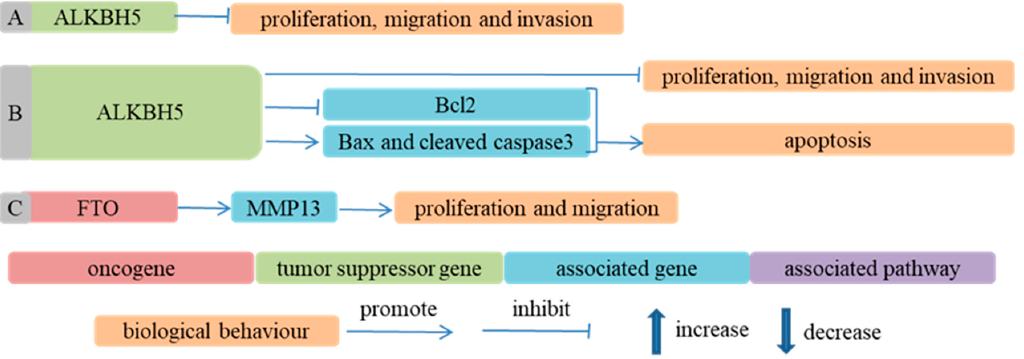
Figure 5. Demethylases participate in ESCA progression in an m 6 A-independent way. ( A ) Ref. [131] ALKBH5 inhibited proliferation, migration and invasion of ESCC cells; ( B ) Ref. [86] ALKBH5 not only inhibited apoptosis of ESCC cells by regulating expression of Bcl2, Bax and cleaved caspase3 but also promoted proliferation, migration and invasion of ESCC cells; ( C ) Ref. [132] FTO facilitated proliferation and migration of ESCC cells through upregulating MMP13 expression.